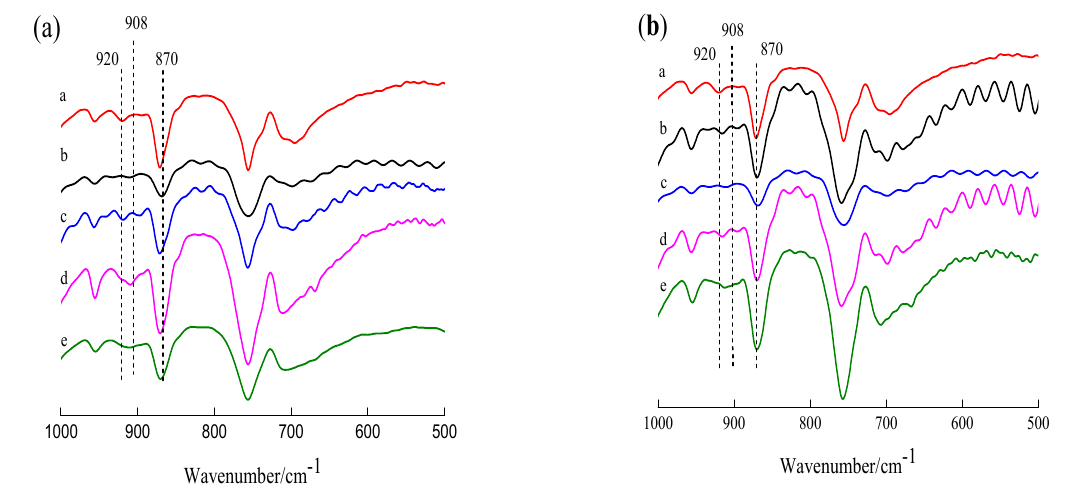
Figure 2. FTIR spectra of PLLA and sc − PLLA ( a ), and sc − PLAG ( b ). ( a ): a. PLLA; b. PDLA; c. m − PLLA − 1; d. m − PLLA − 2; e. m − PLLA − 3; ( b ): a. PLLA; b. PDLAG; c. m − PLAG − 1; d. m − PLAG − 2; e. m − PLAG − 3.